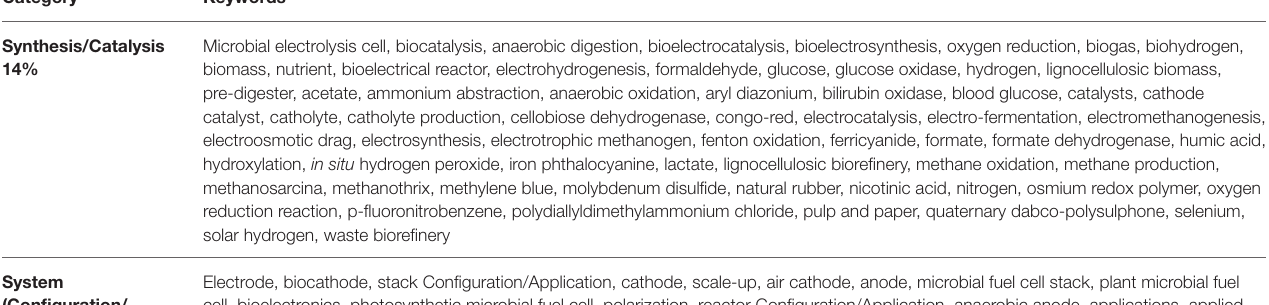
TABLE 3 | Categories related to the author keywords derived from works citing the work of Potter (1911) and the related keywords included in each category.